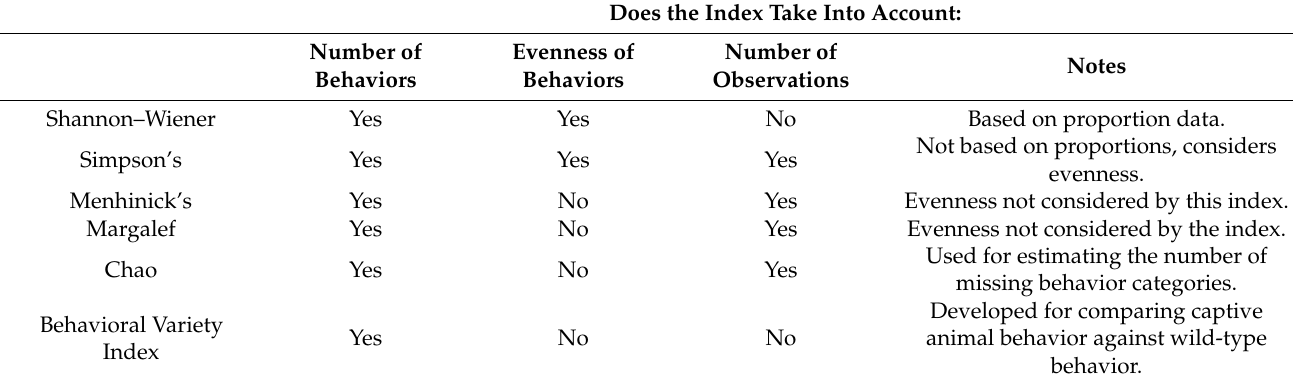
Table 2. Comparison of indices and their potential application to behavioral diversity